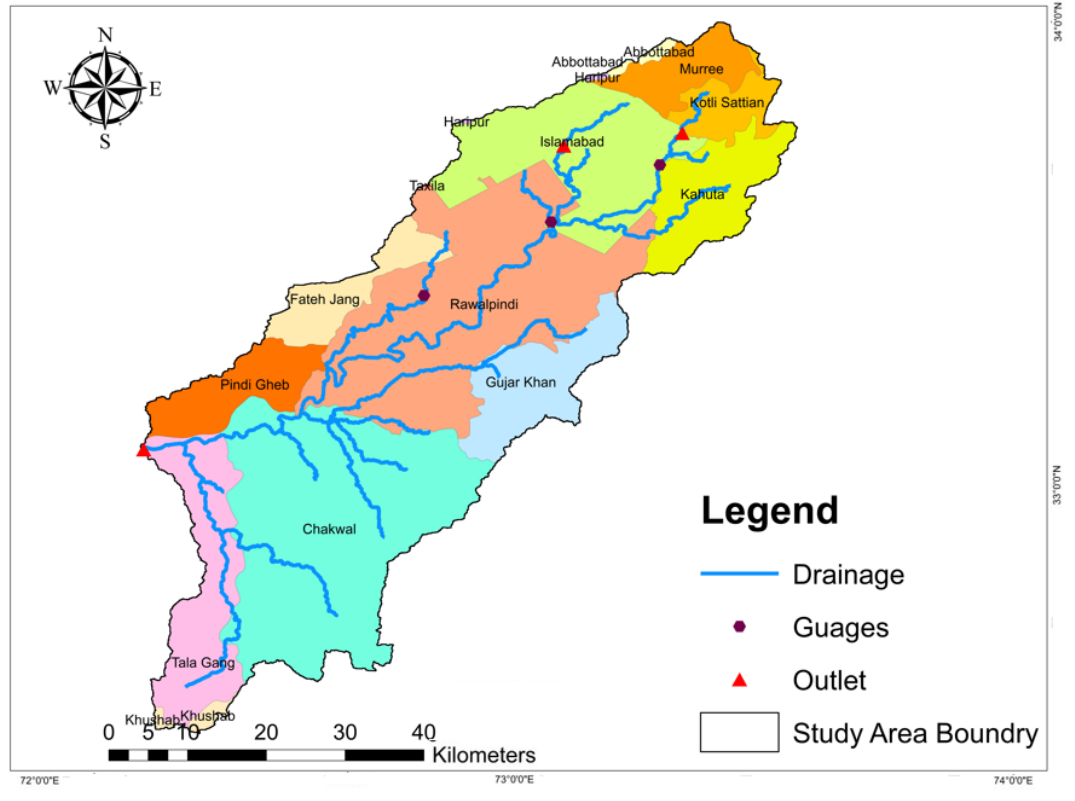
Figure 1. Map of the study area.